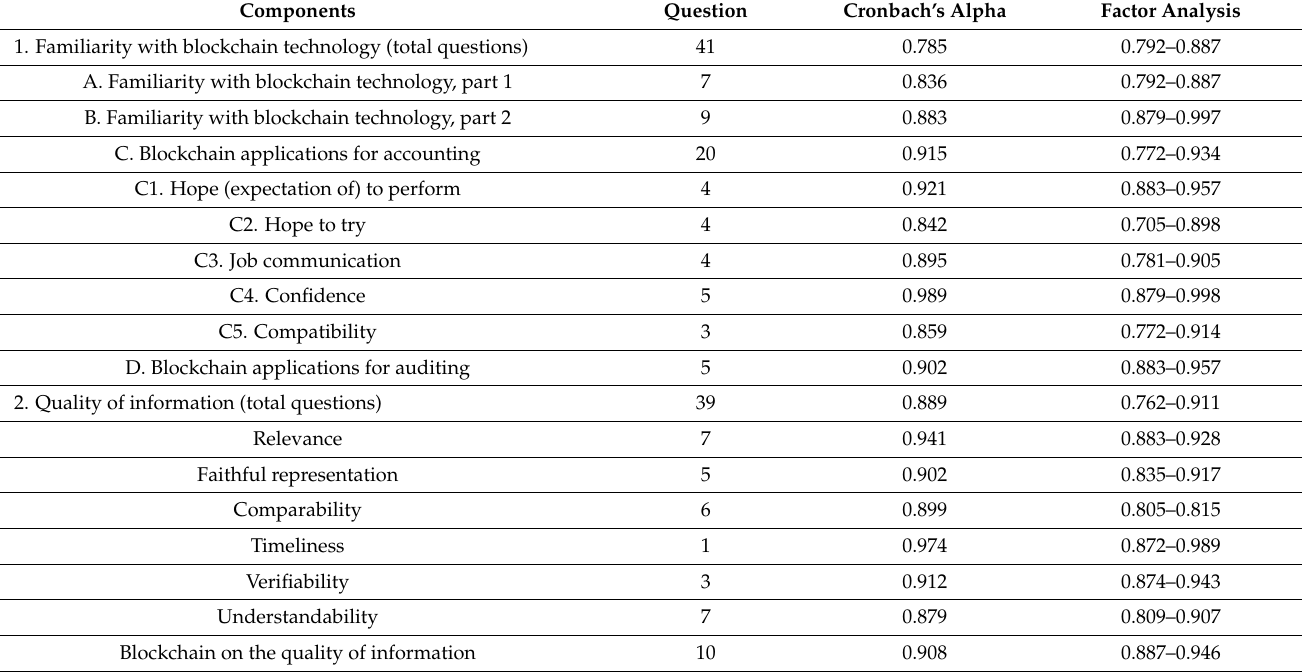
Table 4. The components, number of questions, Cronbach’s alpha, and factor analysis